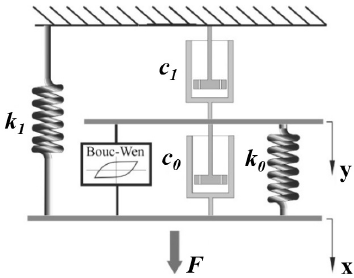
Figure 7. Spencer Dyke model’s